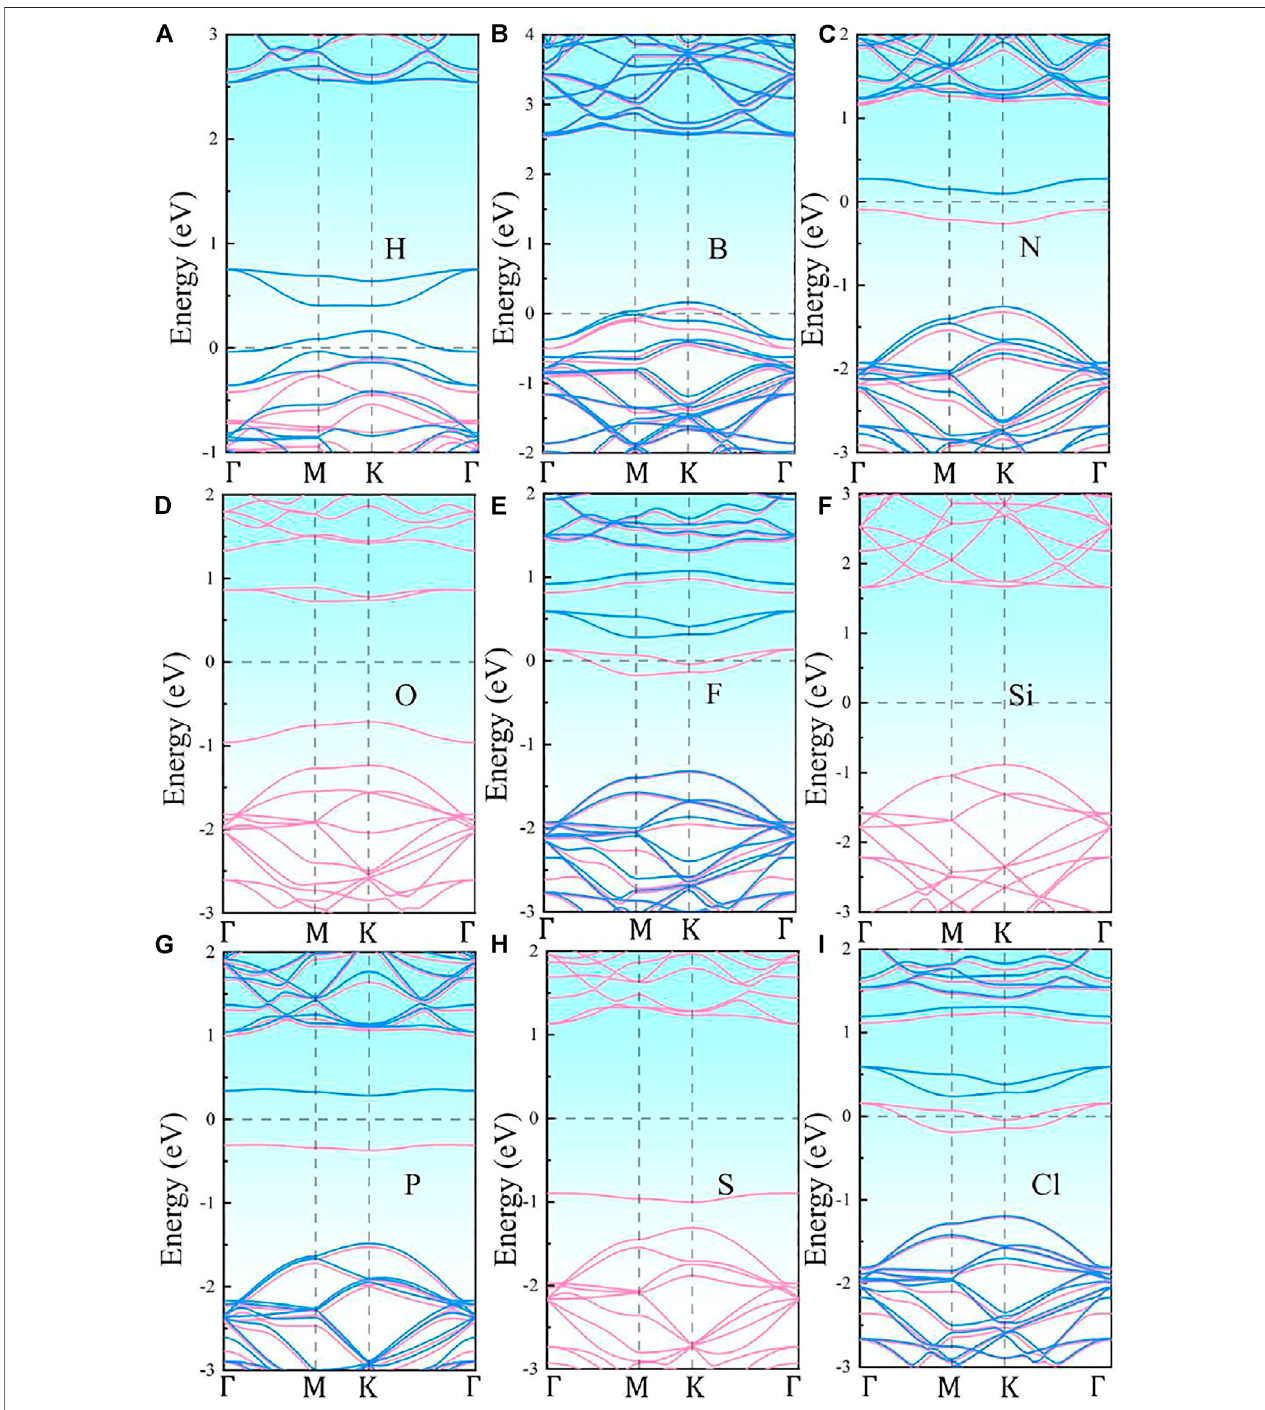
FIGURE 2 | The band structures of NM-SiC systems: (A) H-SiC, (B) B-SiC, (C) N-SiC, (D) O-SiC, (E) F-SiC, (F) Si-SiC, (G) P-SiC, (H) S-SiC, (I) Cl-SiC. The pink lines and the blue lines represent the spin-up, and the spin-down components of energy levels, respectively. The Fermi level is shifted to zero.